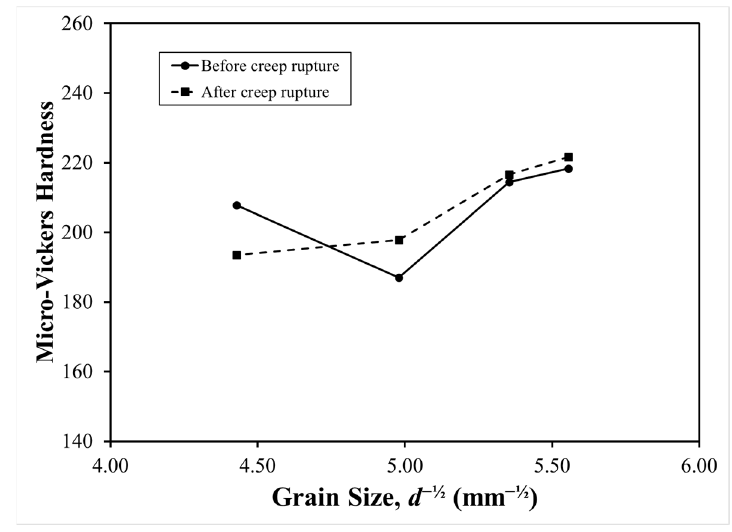
Figure 21. Comparison of hardness vs. grain size before and after the creep rupture test.